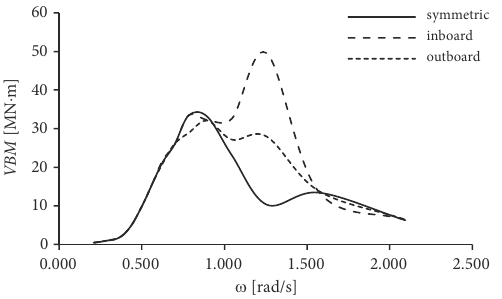
Figure 6. RAOs of vertical bending moments VBM in: a – beam seas; b – bow quartering seas